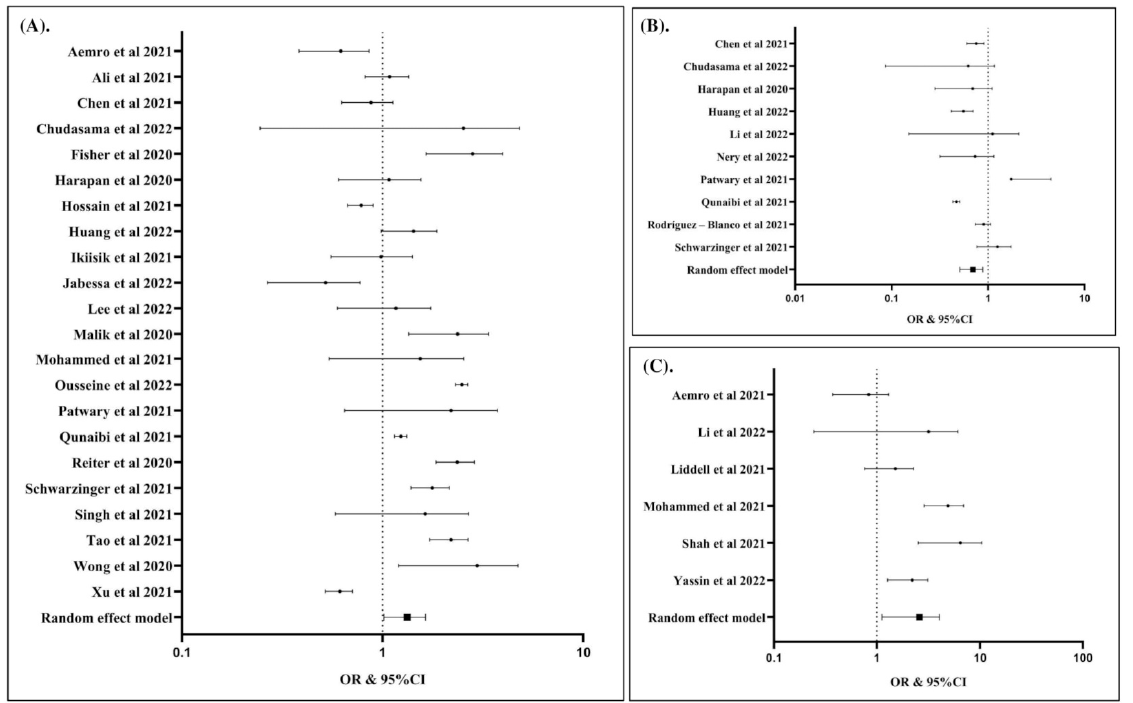
Figure 5. Individuals with the education levels < BSC had higher risk of hesitancy to COVID-19 vaccination than ≥ BSC (OR: 1.30; 95% CI: 1.03, 1.65; p Egger: 0.5260; p heterogeneity: <0.0001; p : 0.0300) ( A ); individuals having the healthcare-related job had lower risk of hesitancy to COVID-19 vaccination (OR: 0.68; 95% CI: 0.52, 0.89; p Egger: 0.3340; p heterogeneity: <0.0001; p : 0.0040) ( B ); Individuals considering that COVID-19 vaccines are not safe had higher risk of hesitancy to COVID-19 vaccination (OR: 2.24; 95% CI: 1.21, 4.14; p Egger: 0.7000; p heterogeneity: <0.0001; p : 0.0100) ( C ). The studies included are provided in the reference list [19,25–79].